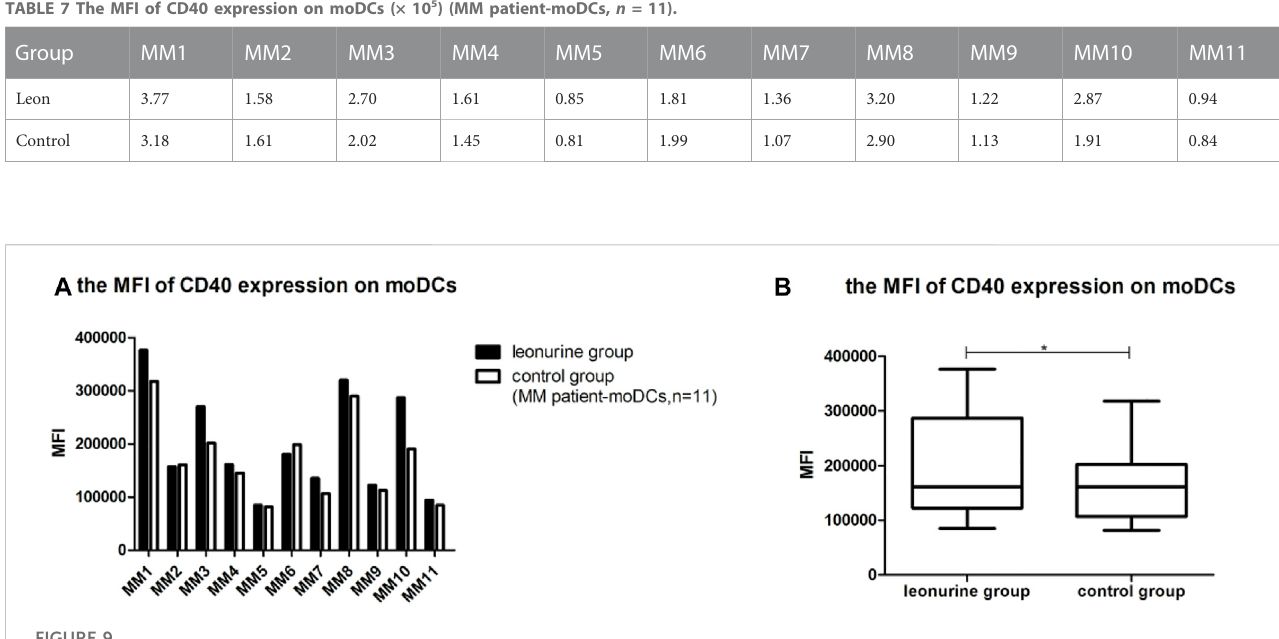
FIGURE 9 TheMFIofCD40expressiononmoDCsbetweentheleonurinegroupandthecontrolgroup(MMpatient-moDCs, n =11). (A) ThegraphshowstheMFIof CD40expressiononmoDCsbetweentheleonurinegroupandthecontrolgroupfor eachMM patient. (B) Theboxplotshowsthat whenmoDCs derivedfrom all 11 MM patients were analyzed together, the MFI of CD40 expression on moDCs was signi fi cantly higher in the leonurine group than in the control group (1.99 × 10 5 ± 0.98 × 10 5 vs. 1.72 × 10 5 ± 0.78×10 5 , p = 0.025, paired-sample t -test).